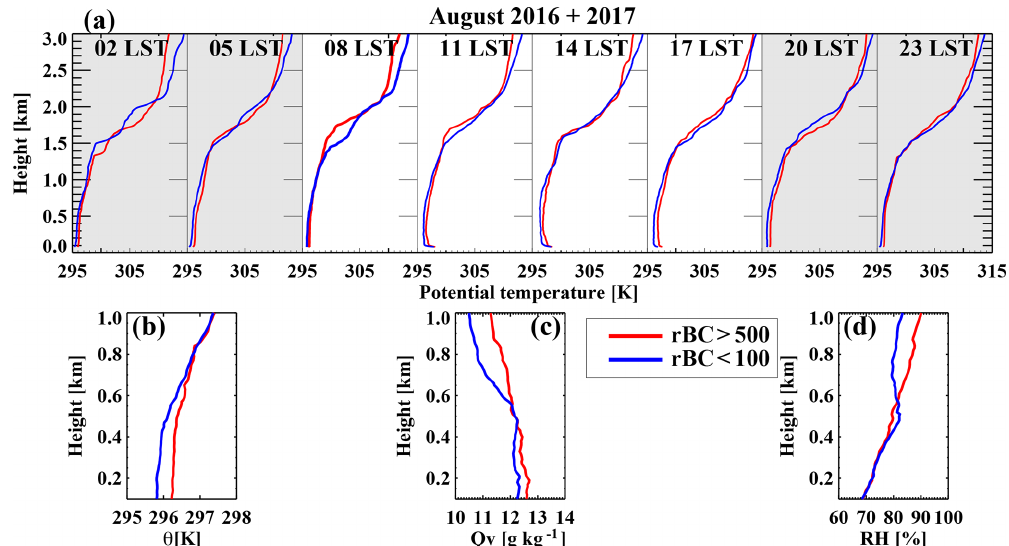
Figure 14. Three-hourly August-mean potential temperature profiles from (a) 100m to 3km, and 08:00LST 100m to 1km profiles for (b) potential temperature ( θ ), (c) water vapor mixing ratio ( Q v ), and (d) relative humidity, composited for “more” (red) and “less” (blue) smoke loadings.